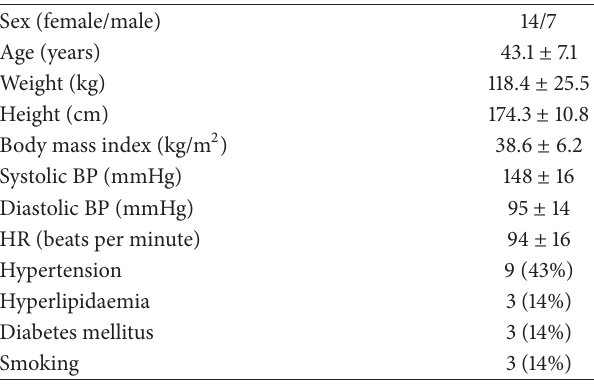
Table 1: Clinical characteristics ( 𝑛 = 21 ).